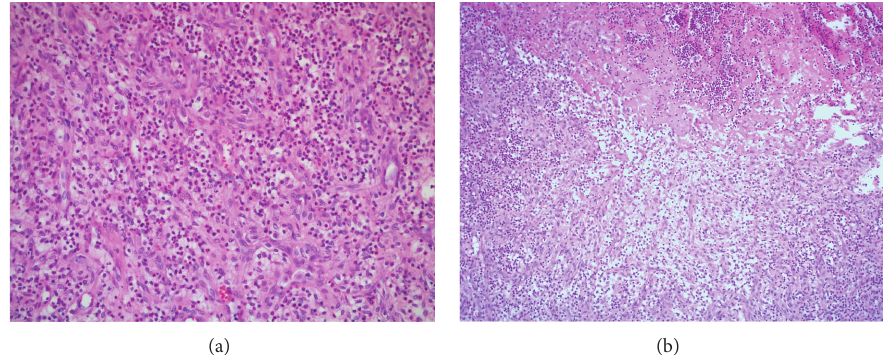
Figure 1: Synovial biopsy. Active inflammation and granulation tissue, predominantly composed of neutrophil leukocytes. Hematoxylin and eosin, × 100 (a) and × 200 (b) magnification.